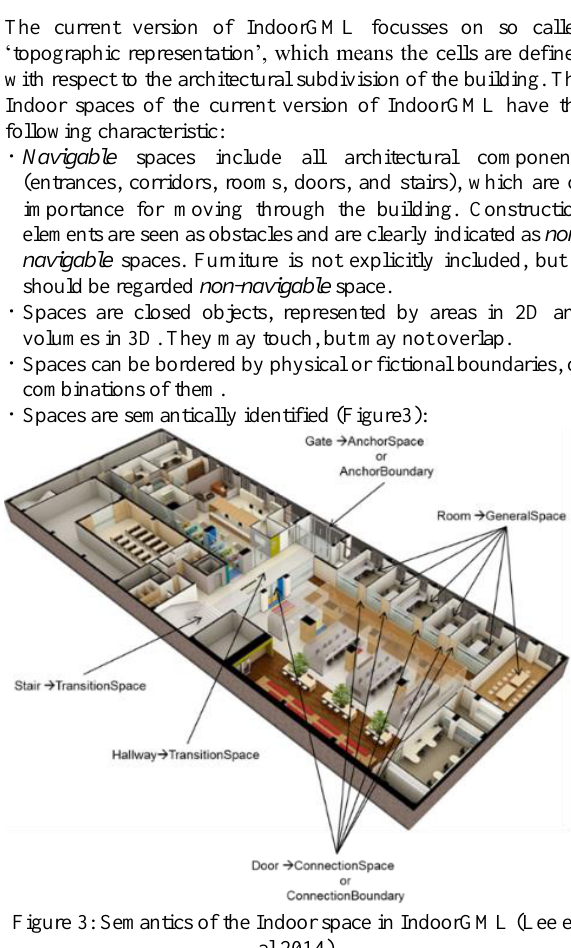
Figure 1: The general concept of IndoorGML: 3D model of a building (left); room (green) and door (brown) spaces used for navigation (right up); navigation network (right-down)